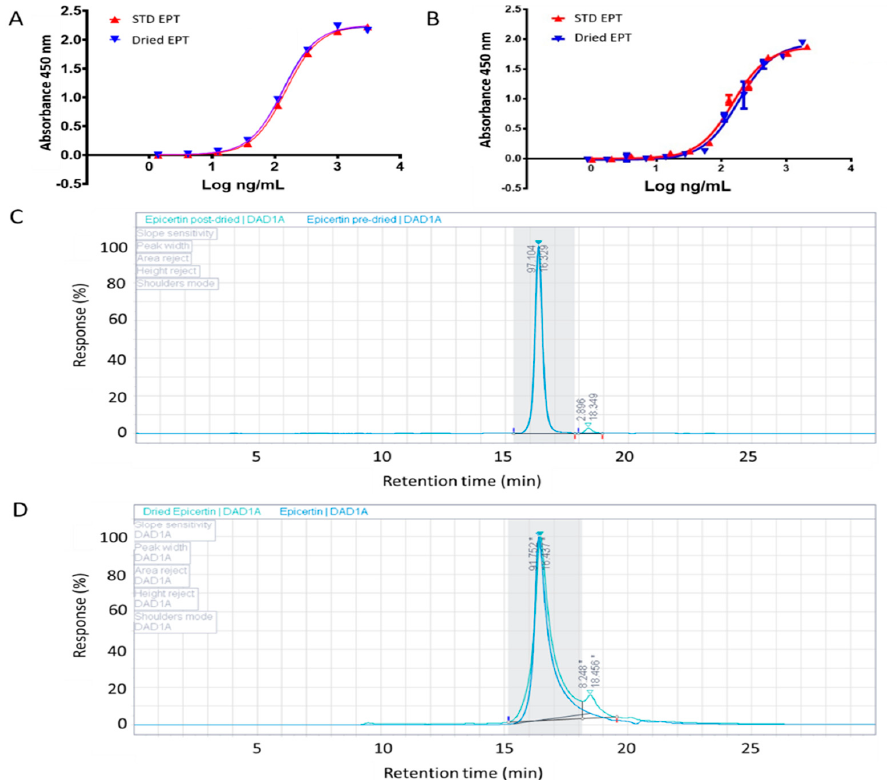
Figure 1. Stability assessment of spray dried EPT. The production of EPT standard is described in the methods section. The stability of dried EPT post-drying and after 9 months was assessed by GM1 − capture KDEL − detection ELISA and SEC-HPLC. A representative binding curve of spray dried EPT is shown for ( A ) one day post-drying and ( B ) after 9 months stored at 23 ◦ C in a desiccator, compared to an EPT standard. SEC-HPLC chromatogram of ( C ) non-dried EPT (blue) and EPT one day post-drying (green) and ( D ) dried EPT (green) after 9 months stored at 23 ◦ C in a desiccator (EPT standard is in blue). After 9 months dried EPT contained 91.8% pentamer and 8.2% monomer (* represents a line drop as the two peaks are not completely resolved). The resolution value of the two peaks is 1.6 (determined by OpenLab CDS 2.1 software, Agilent Technologies, Santa Clara, CA, USA).